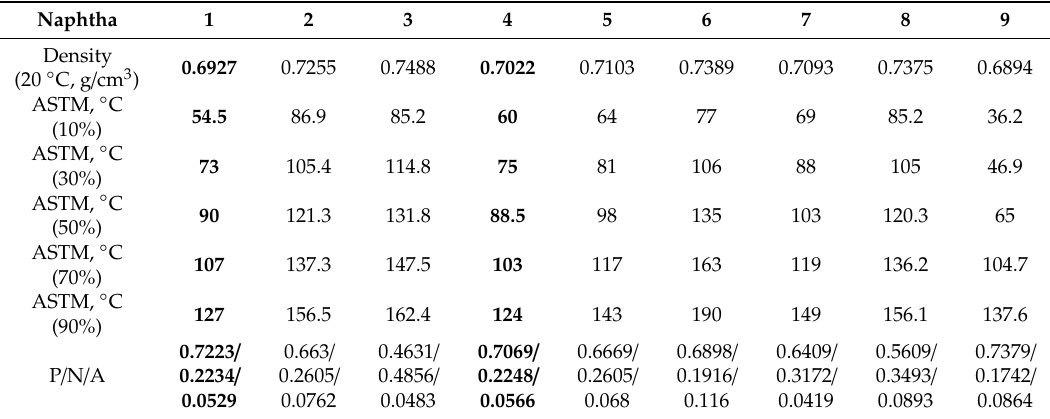
Table 6. Character parameters of naphthas (1) to (9)